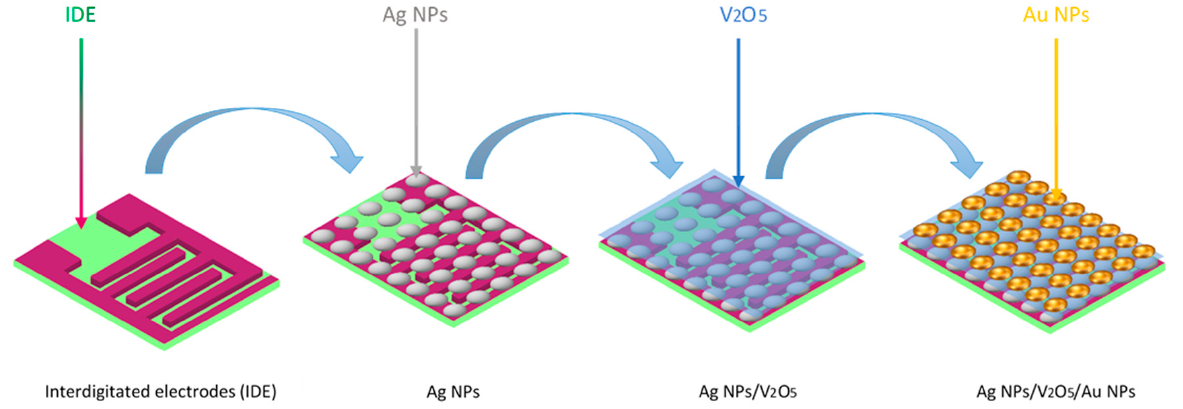
Figure 1. Schematic diagram of the preparation process of Ag NPs/V 2 O 5 thin fi lm/Au NPs.